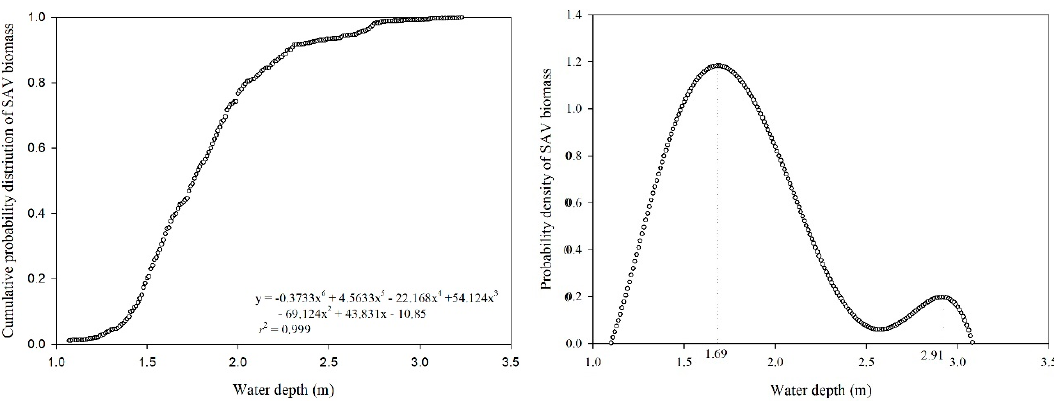
Figure 8. Cumulative probability and probability density curve of the submerged aquatic vegetation (SAV) biomass.